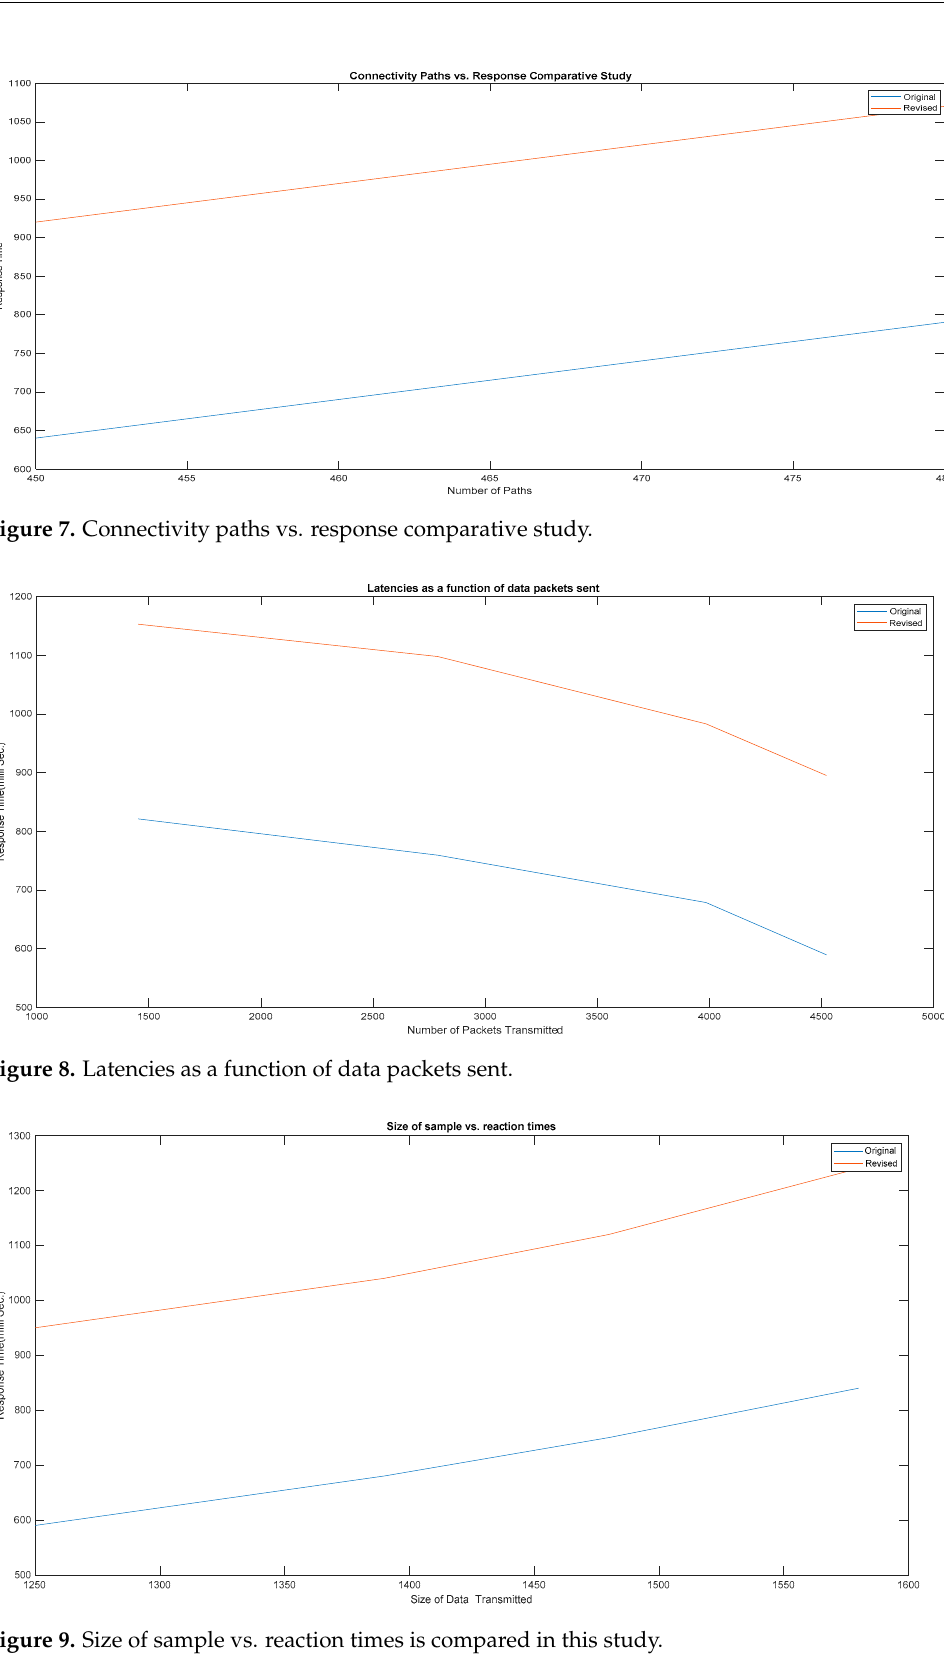
Figure 9. Size of sample vs. reaction times is compared in this study.